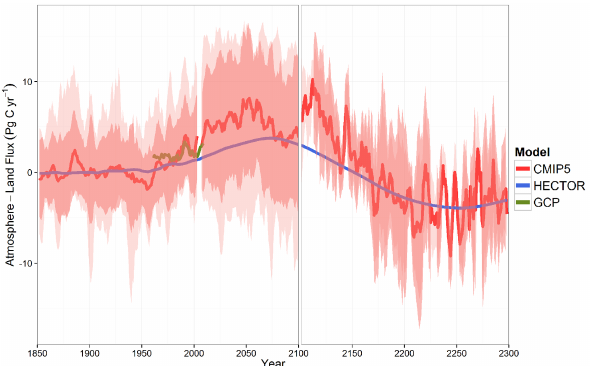
Figure 10. Global air–land fluxes of carbon under RCP 8.5; Hector (blue); CMIP5 median, standard deviation, and model range (pink, n = 8 (1850–2100) and n = 2 (2101–2300)); and observations from GCP (green) (Le Quéré et al., 2013). The break in the graph at 2100 signifies a change in the number of models that ran the RCP 8.5